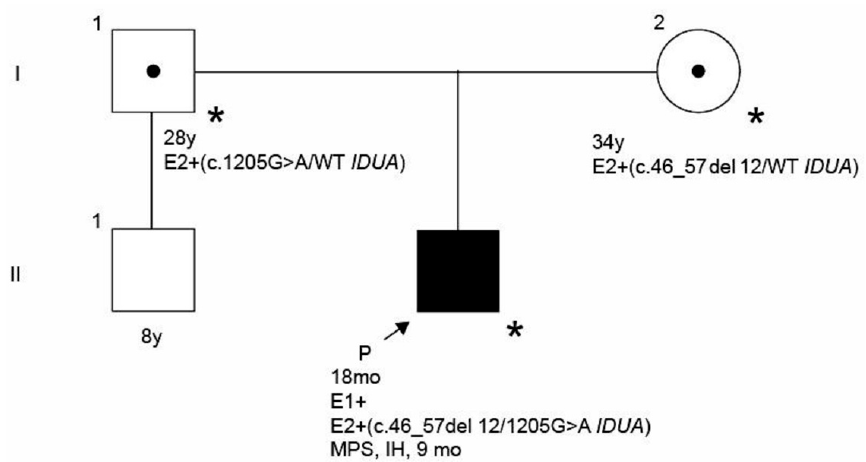
Figure 1. Pedigree of the index patient’s family. Abbreviations: E1 = enzyme assay; E2 = gene sequencing for IDUA; mo: months; MPS-IH: Mucopolysaccharidosis type I, Hurler; WT: wild-type; y: years.